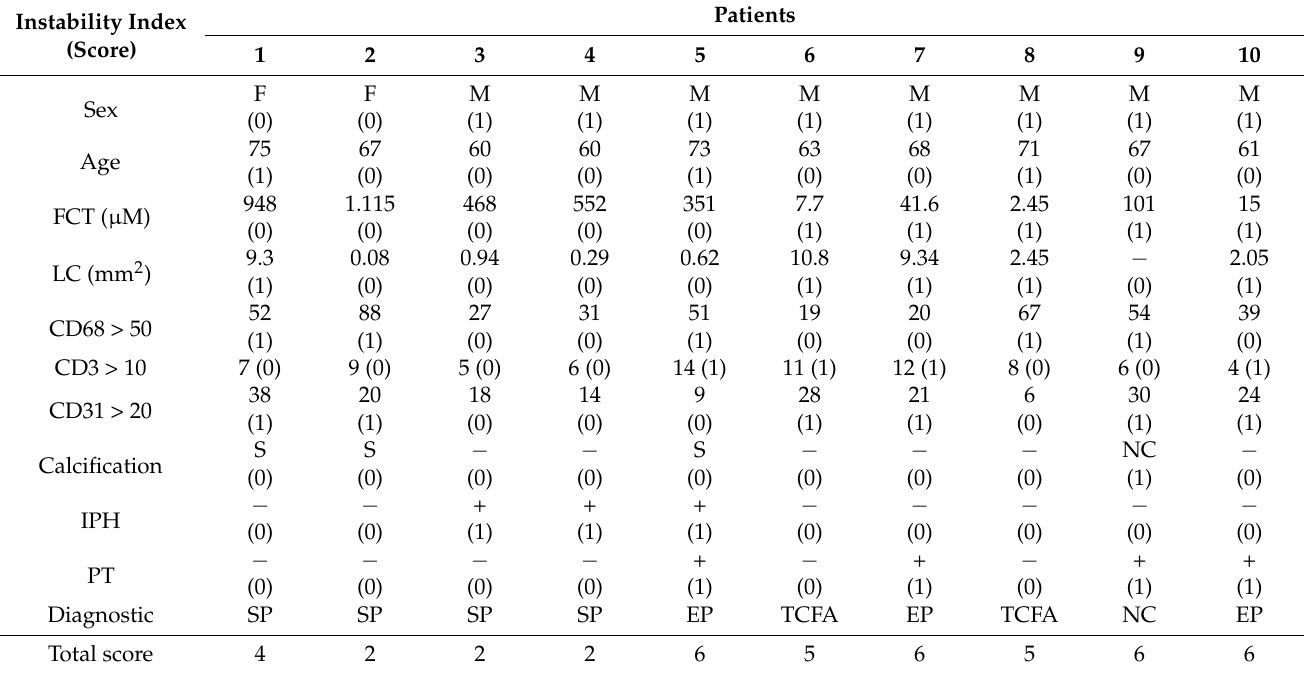
Table 2. The proposed plaque instability index in studied patients ( n = 10).